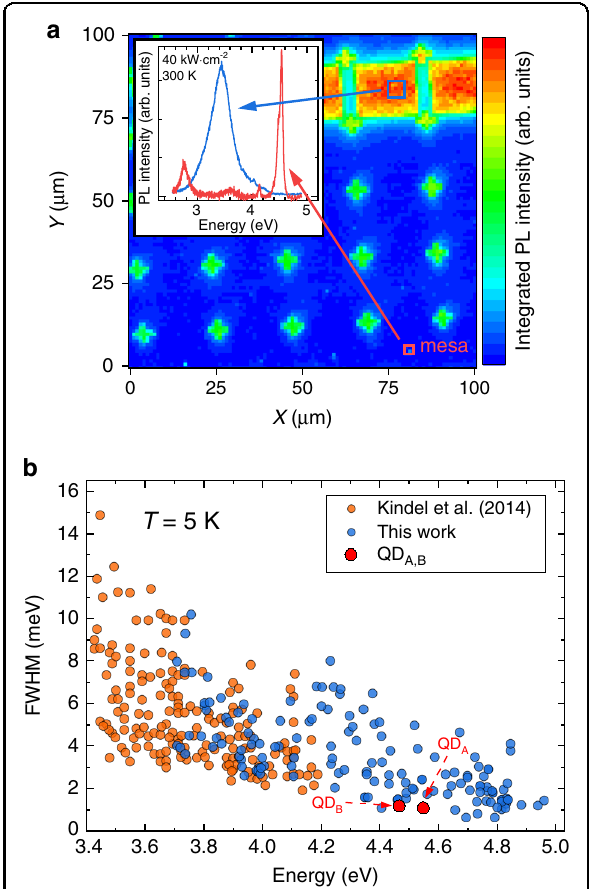
Fig. 1 Photoluminescence characteristics of the SA GaN/AlN QD sample. a 100 × 100 µm 2 micro-photoluminescence mapscan of the patterned sample for which the signal is recorded at 300 K and integrated between 2.5 and 4.5 eV. Spatially resolved micro- photoluminescence integrated intensity images are recorded using steps of one µm. The strongest signal is measured from unprocessed areas with a high QD density. Inset: Typical µ-PL spectrum collected from an unprocessed area (blue line) and from a mesa (red line). b Full width at half-maximum (FWHM) distribution of GaN/AlN excitonic emission recorded at low temperature ( T = 5 K) in the cw low excitation regime. Orange dots correspond to QDs grown by metalorganic vapor-phase epitaxy on SiC studied by Kindel et al. 18 . All blue data points were extracted from the same sample. Autocorrelation measurements described in the following are performed on the QDs labeled QD A and QD B